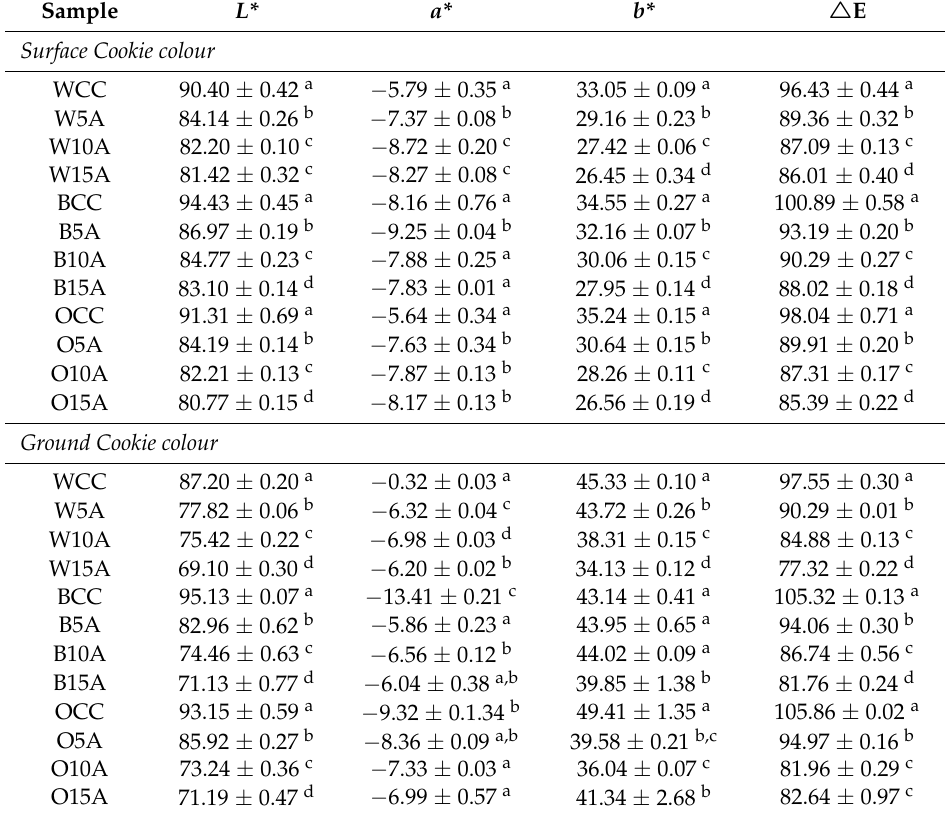
Table 3. The CIE colour profiles of the cookies.